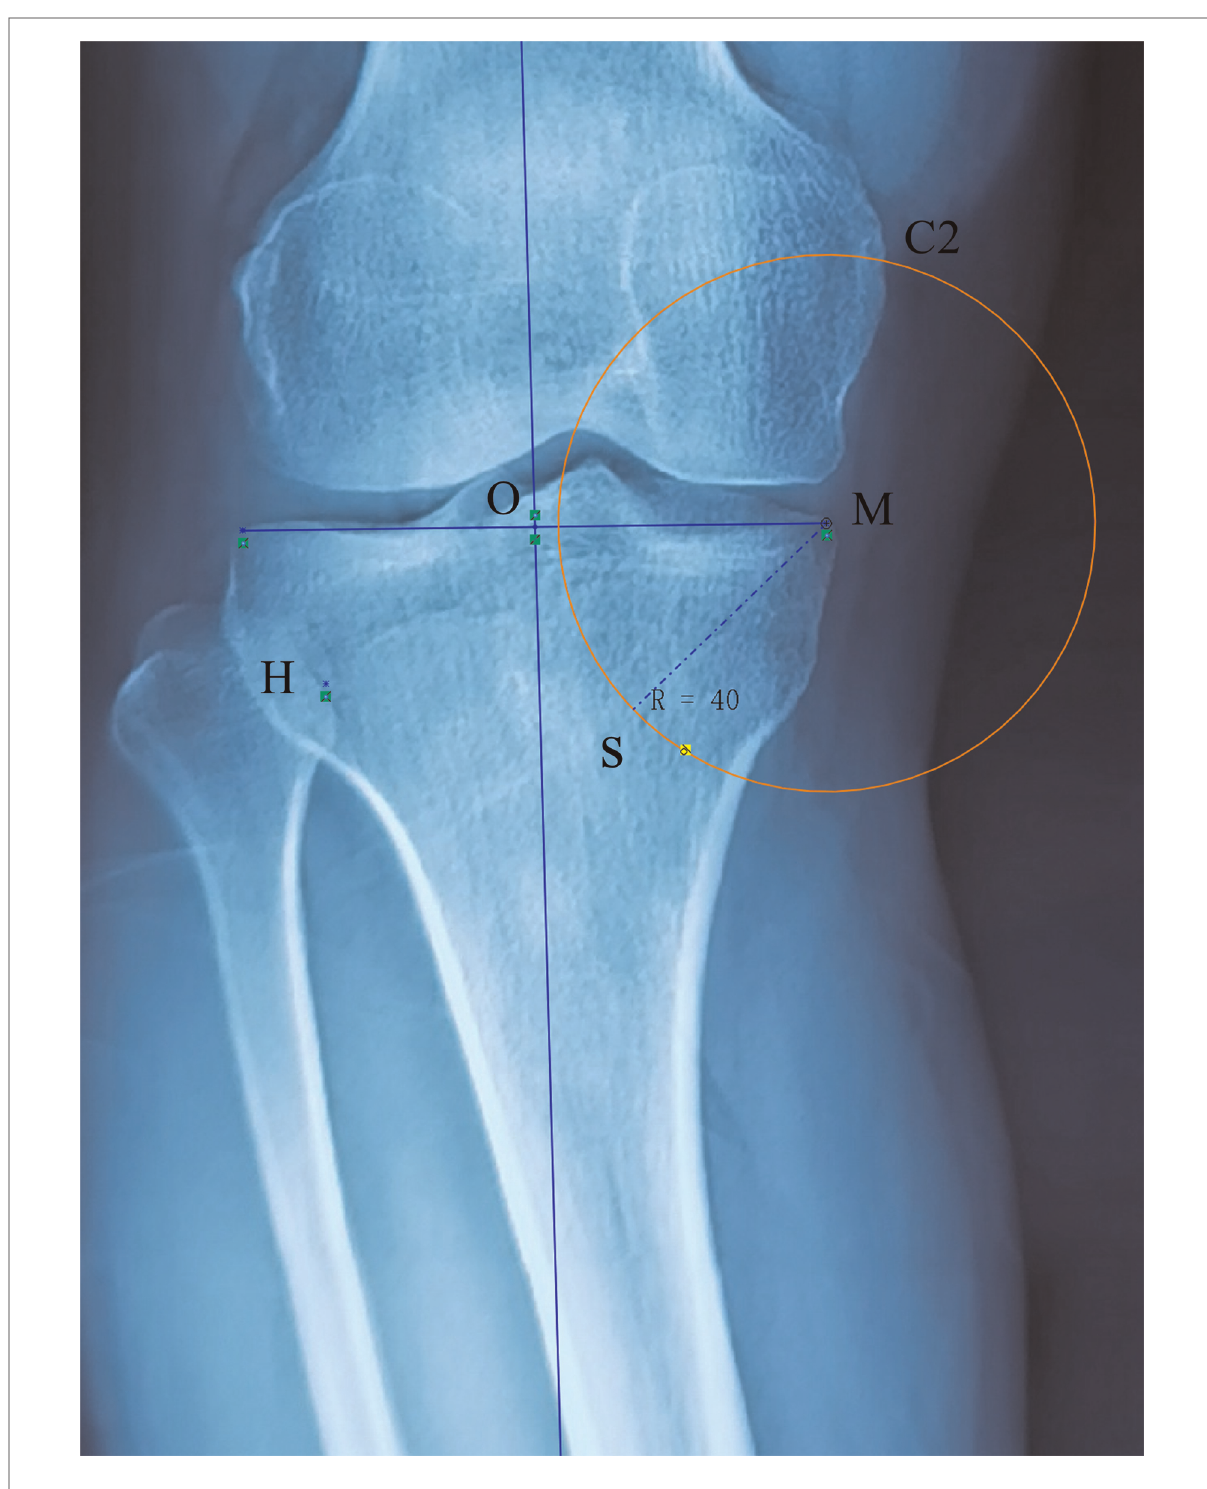
FIGURE 3 Point M represents the medial border of the tibial plateau. With M as the center and a concentric circle was drawn with a radius of 40 mm, which intersected at point S of the medial cortex of the tibia. Point S was selected as the osteotomy